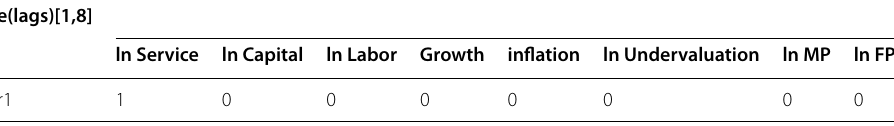
Table 13 Panel ARDL Lag determination. Source: Author calculations